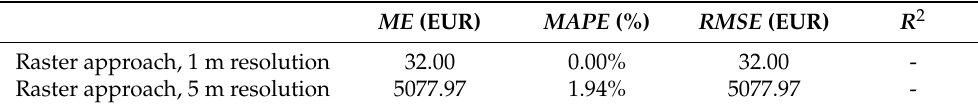
Table 7. Statistical analysis of the LATIS tool with respect to the FLIAT tool for the entire road network in Ghent (N = 1).